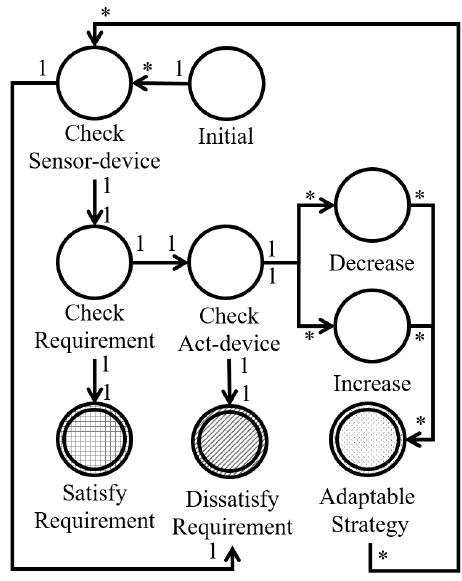
Figure 2. Relationship of IoT-FSM state